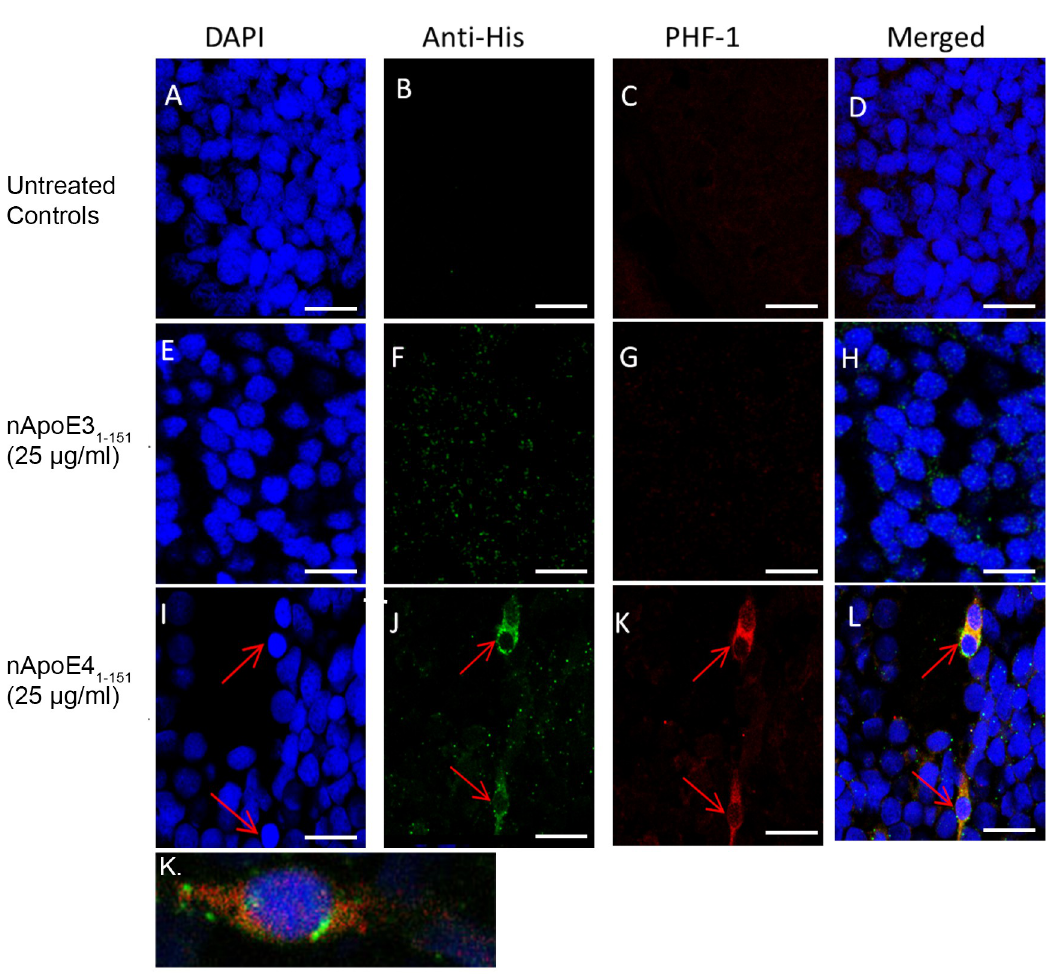
Fig 5. Tau pathology present after treatment with exogenous nApoE4 1-151 fragment in 72 hpf zebrafish brain. Representative 40X images from confocal immunofluorescence in 5 mm paraffin embedded sections of non-treated control 72 hpf zebrafish (A-D), nApoE3 1-151 -treated at 25 μ g/ml (E-H), or nApoE4 1-151 -treated at 25 μ g/ml (I-L). Strong PHF-1 labeling was only observed following treatment with nApoE4 1-151 (I-L). Panel K depicts a separate, representative merged image following treatment with nApoE4 1-151 . In this case, at high magnification the fibrillar nature of PHF-1 labeling was apparent. All scale bars represent 50 μ m. Data are representative of three independent